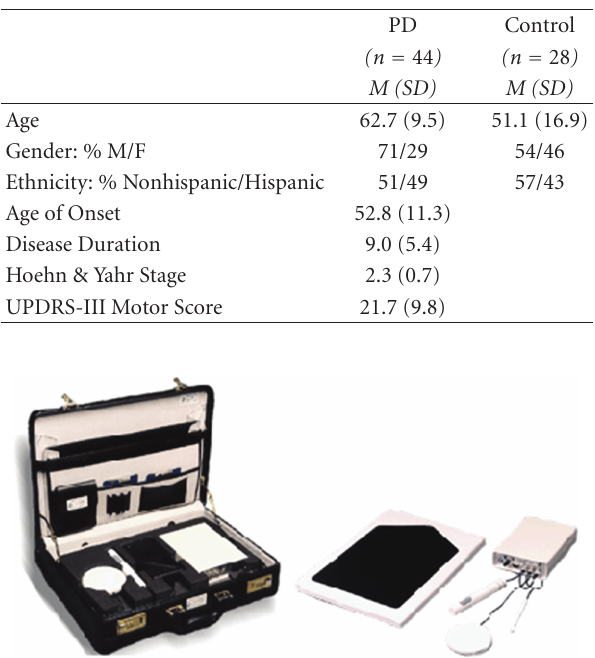
Figure 1: The Coordination Ability Test System (CATSYS) includ- ing a data logger and four di ff erent sensors: a tremor pen, a touch recording plate, a reaction time handle, and a force plate for balance (static posturography)